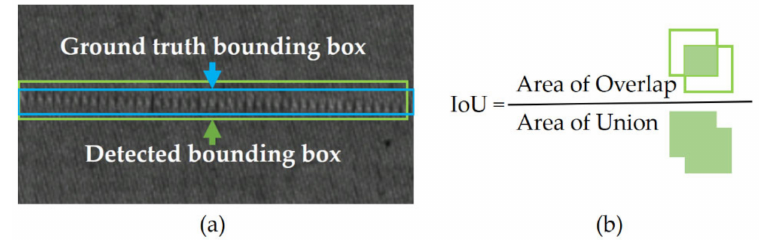
Figure 8. Intersection over union (IoU) of the detected defect and the ground truth. ( a ) the detected defect and the ground truth, and ( b ) the schematic of IoU.